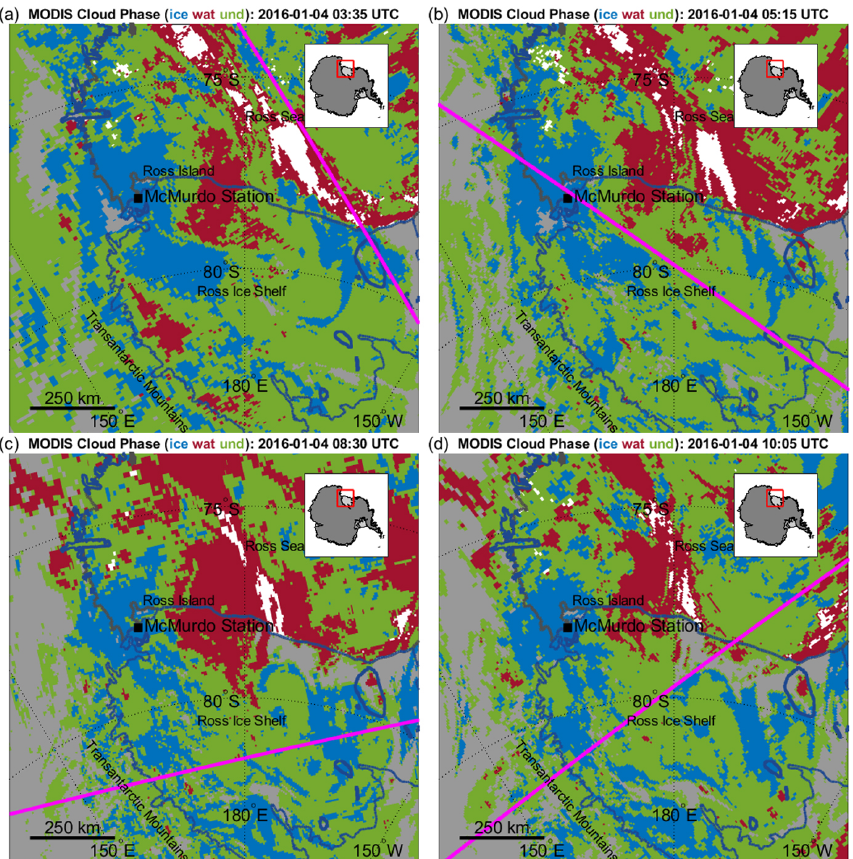
Figure 3. Time evolution of cloud top phase (ice, liquid or undetermined in blue, red and green, respectively) retrieved by subsequent MODIS overpasses on 4 January at (a) 03:35, (b) 05:15, (c) 08:30 and (d) 10:05UTC within the geographical area shown in Fig. 2a. The magenta lines correspond to the satellite ground track for each